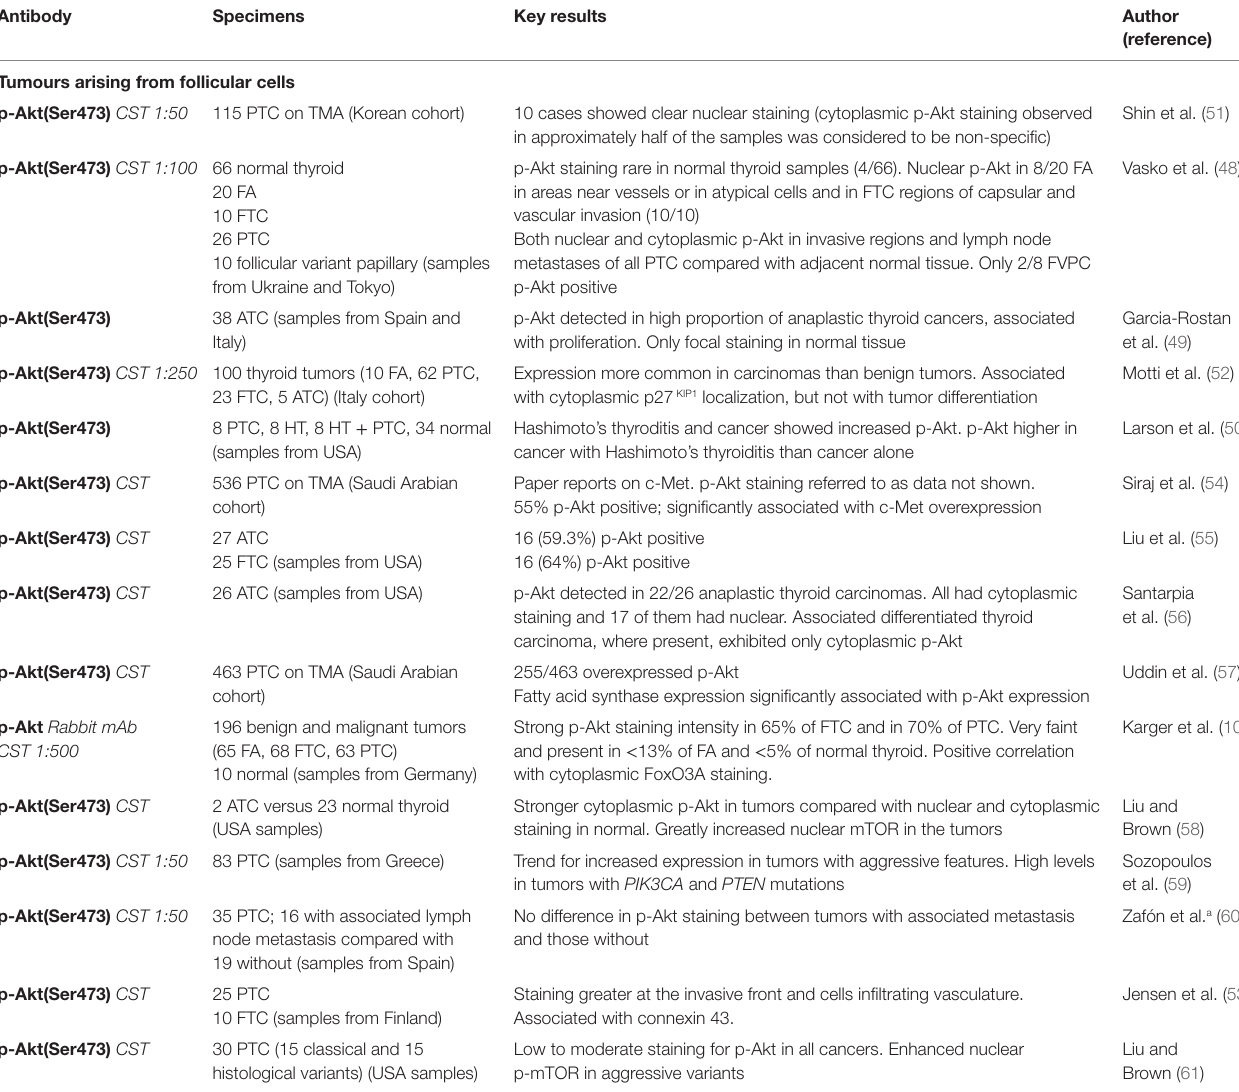
TABLe 1 | Results of immunohistochemical staining studies for p-Akt(Ser473) in thyroid